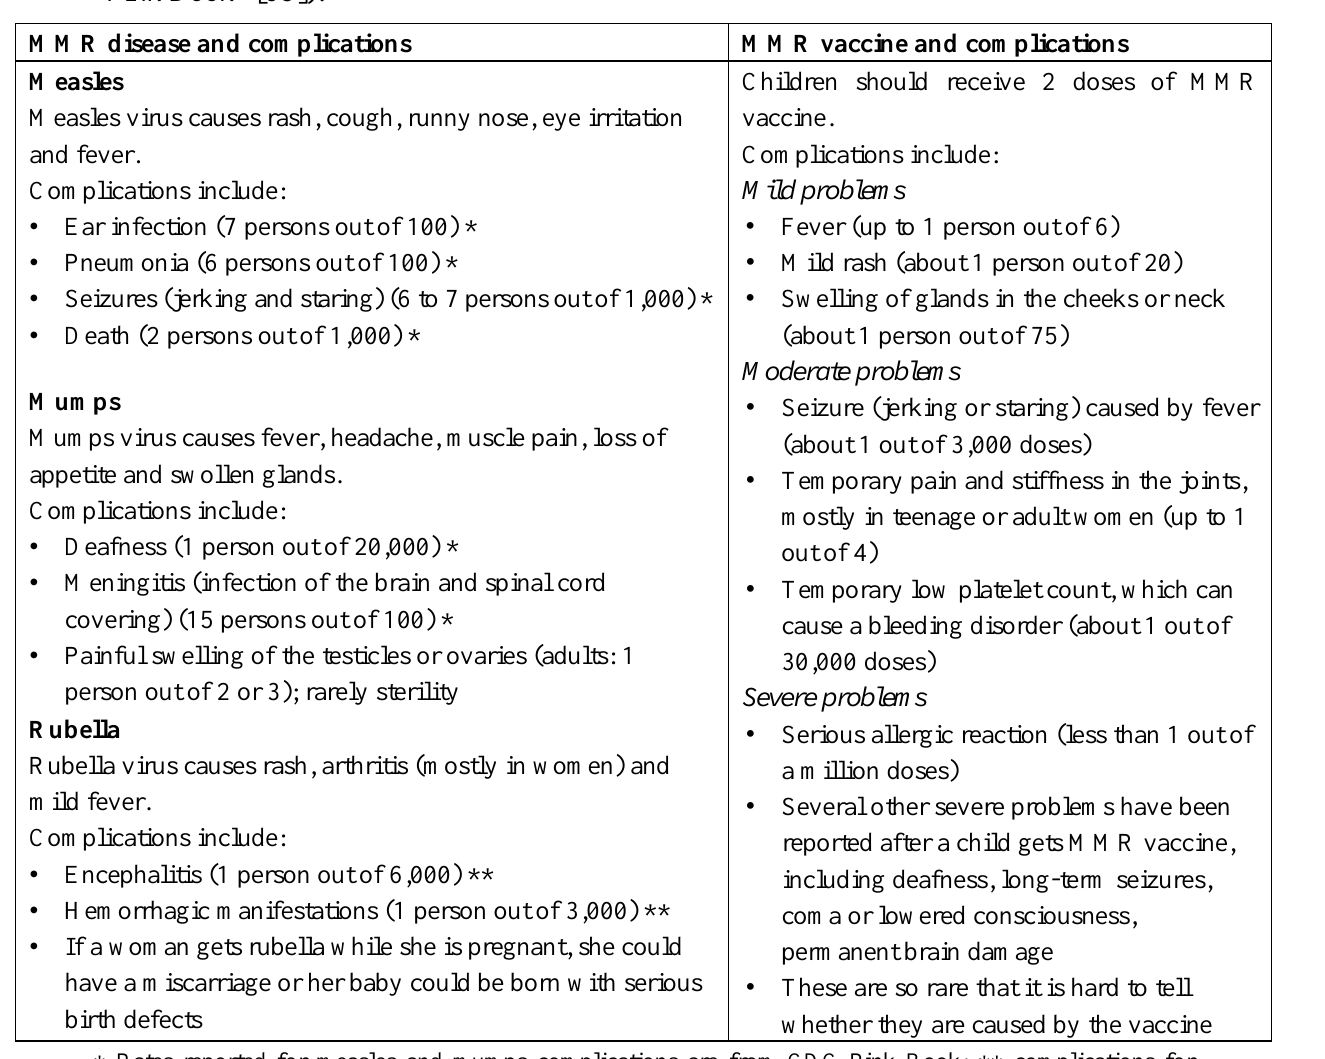
Table 2. An example vaccine information statement (VIS) for the measles, mumps and rubella (MMR) vaccine (adapted from VIS produced by the CDC [92] and data in the CDC ―Pink Book‖